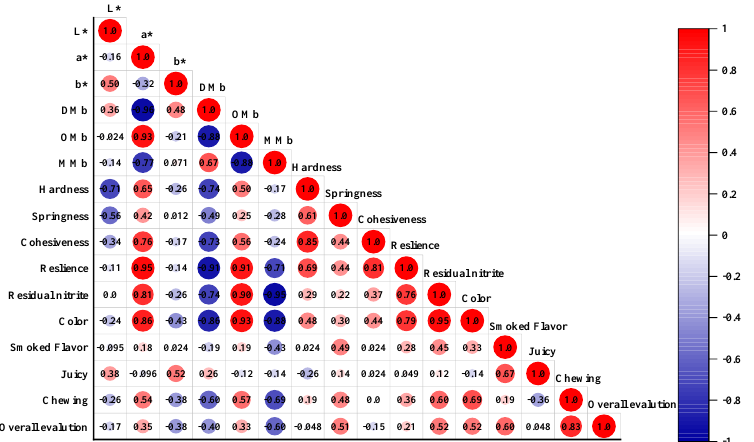
Figure 8. Correlation analysis of the color, texture, residual nitrite, and sensory quality in the smoked sausages.